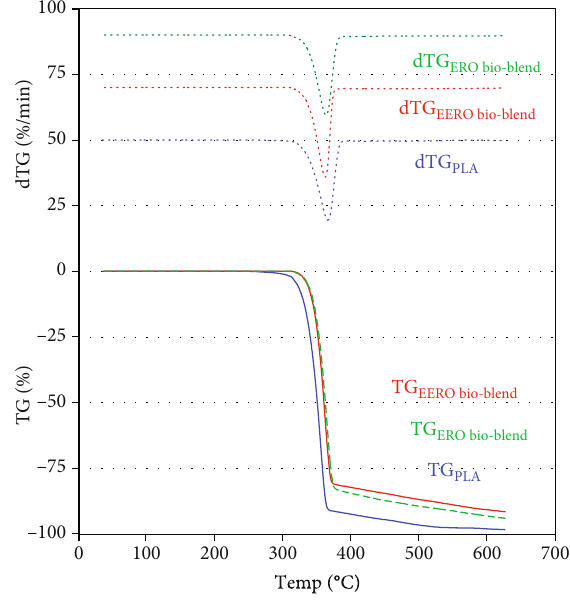
Figure 6: TG and dTG thermograms of samples. Table 4: The thermal stability factors of samples.